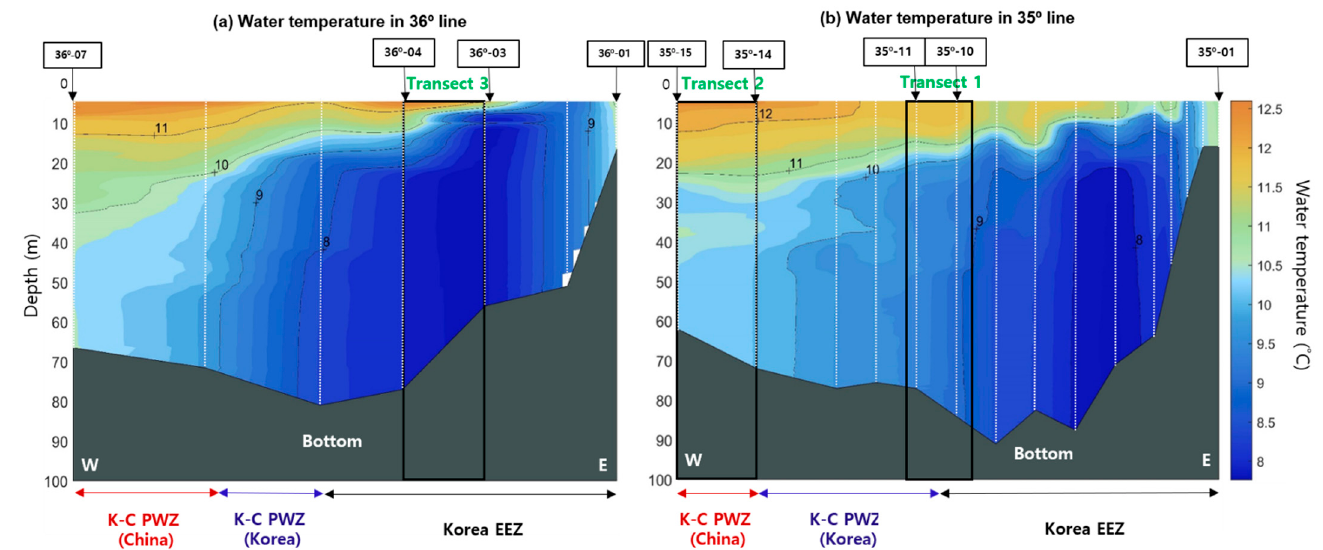
Figure 7. Spatial distribution of water temperature in the ( a ) 36° and ( b ) 35° lines from CTD stations in the YSBCW. In the figure, W is west, E is east, and the depth is divided by 10 m. White dotted lines and grey regions are CTD stations and bottom, respectively.